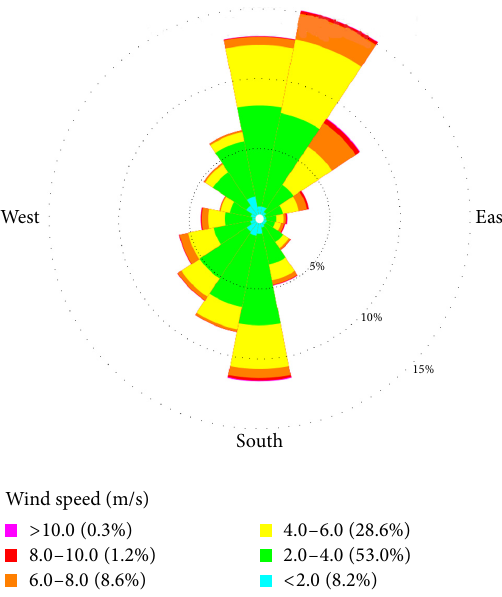
Figure 10: Polar diagram: wind direction for